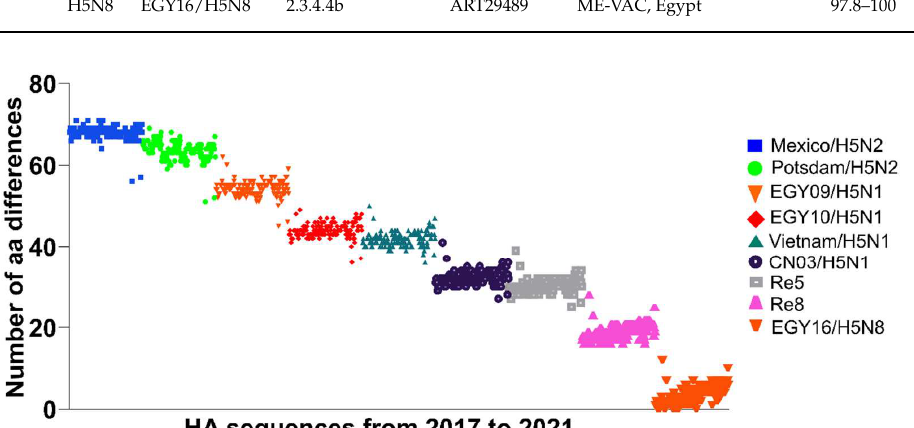
Figure 4. Number of amino acid differences of Egyptian H5N8 from 2017 to 2021 compared to se- lected vaccine strains. HA sequences of viruses isolated from 2017 (blue), 2018 (green), 2019 (or- ange), 2020 (pink) and 2021 (red) were compared to vaccine strains. Clade 2.3.4.4 EGY16/H5N8 (up- per left) and Re8 (upper right) are commonly used in poultry in Egypt, while historic H5N2 virus- based vaccines (lower panels) are less used. Although clade 2.3.4.4 viruses are closely related to the Egyptian viruses, there is an increasing number of aa differences in the Egyptian H5N8 viruses par- ticularly from 2020/2021 compared to the H5N2 vaccines. For the abbreviations of the vaccine strains, refer to Table 2.